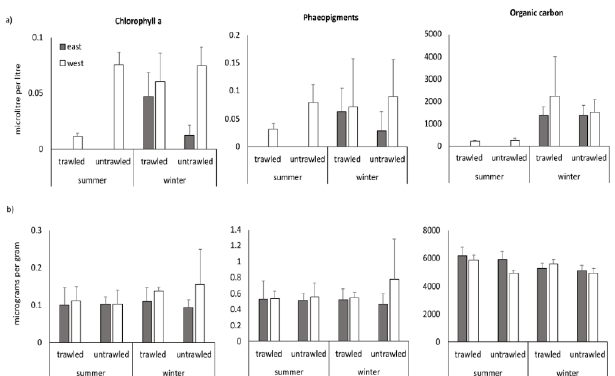
Figure 3. ( a ) Bottom water and ( b ) sedimentary chlorophyll a, phaeopigments and organic carbon from the Heraklion Bay trawled and untrawled sampling sites with mean and standard deviation in summer and winter. Grey bars indicate the eastern sites and white bars the western sites. Table 2. Three-way ANOVA results for the comparisons of the bottom water and sedimentary environmental variables as well as oxygen flux for the factor trawling, season and site. Significant differences at p < 0.05 indicated with “*”, at p < 0.01 indicated with “**” and non-significant indicated with